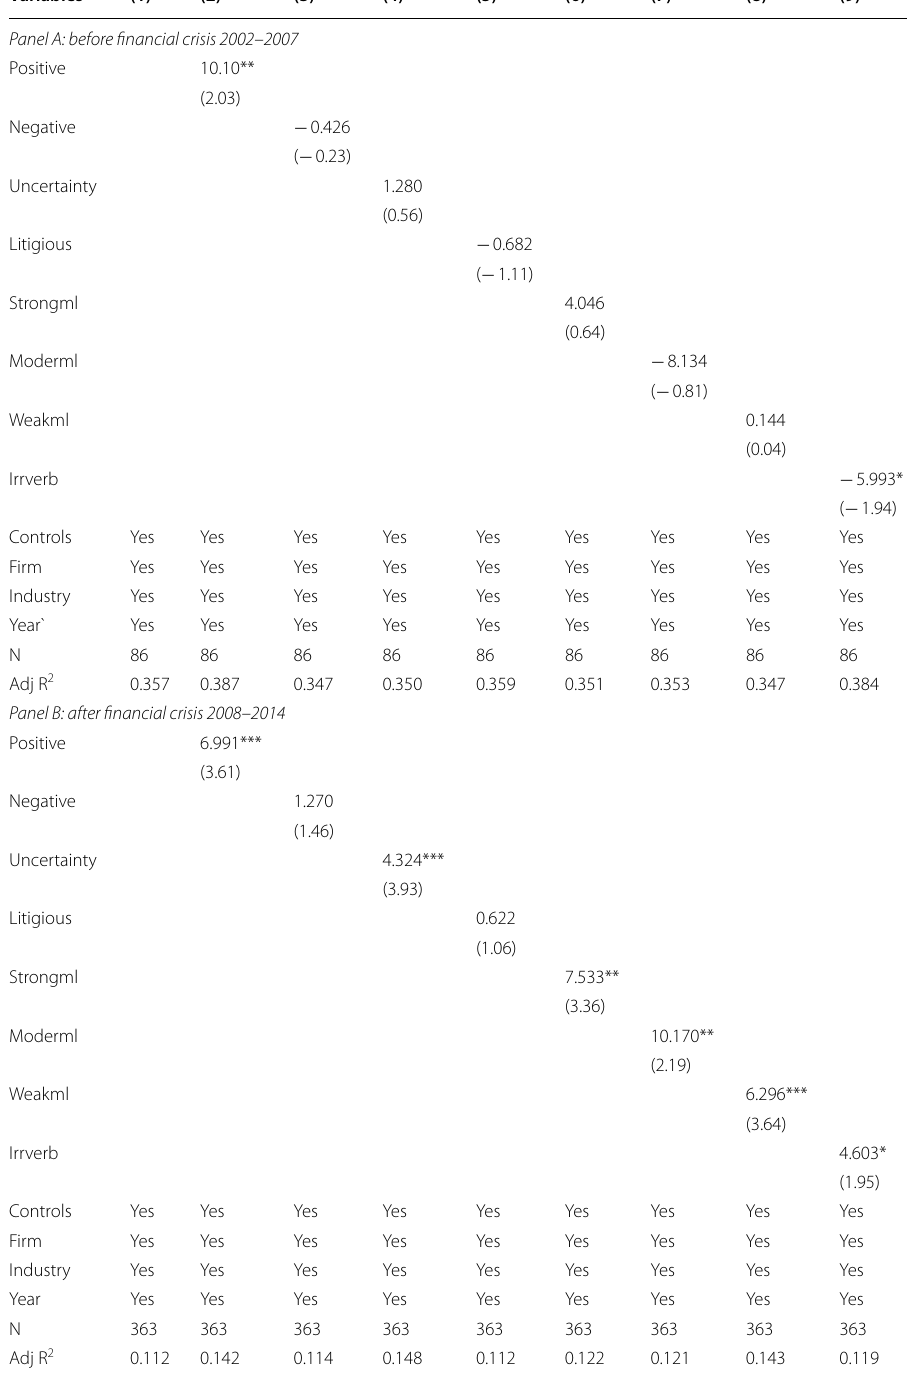
Table 7 The impact of financial crisis on earnings